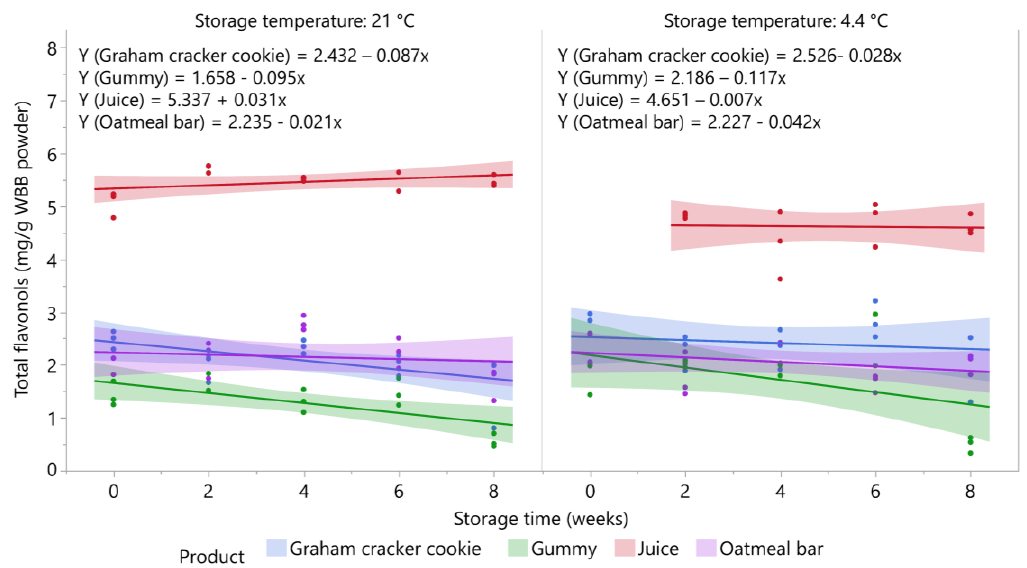
Figure 6. Stability of total flavonols in blueberry stored at 21 °C and 4.4 °C ( n = 3/time point). Shaded area around lines represents 95% confidence intervals for predicted values.